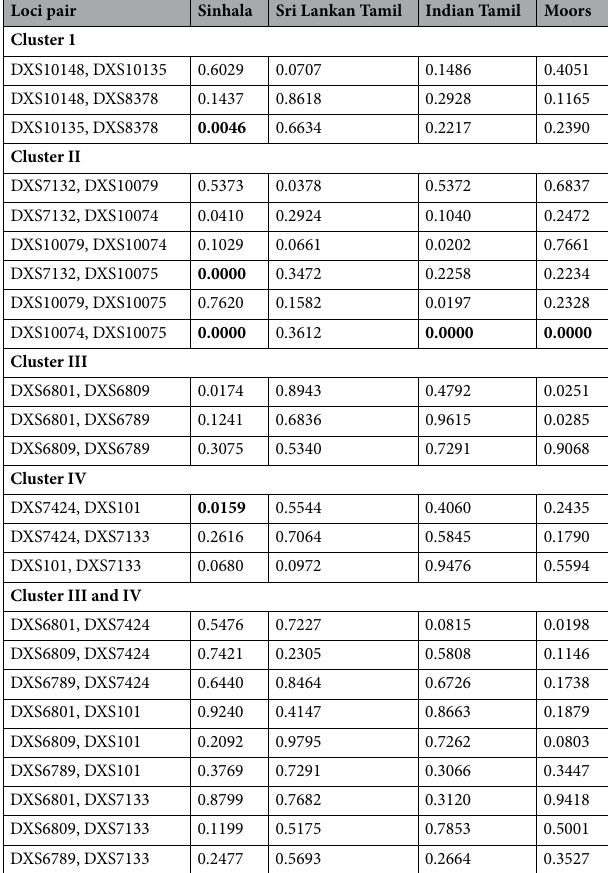
Table 4. P values for pairwise linkage disequilibrium results for the four ethnicities. Significant P values (after correcting for multiple comparisons) are indicated in bold font.